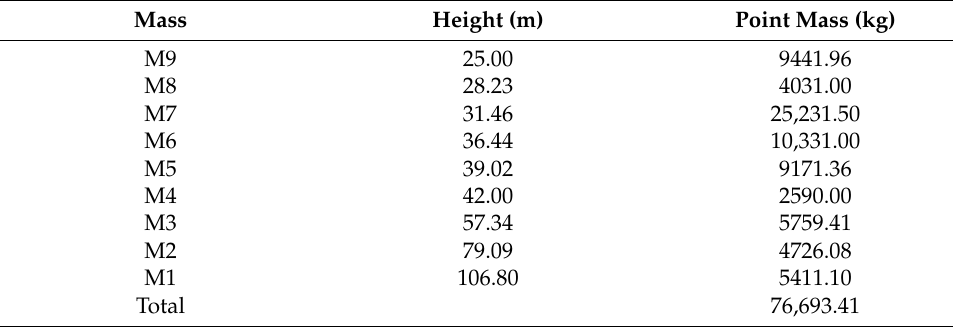
Table 4. Support structure node